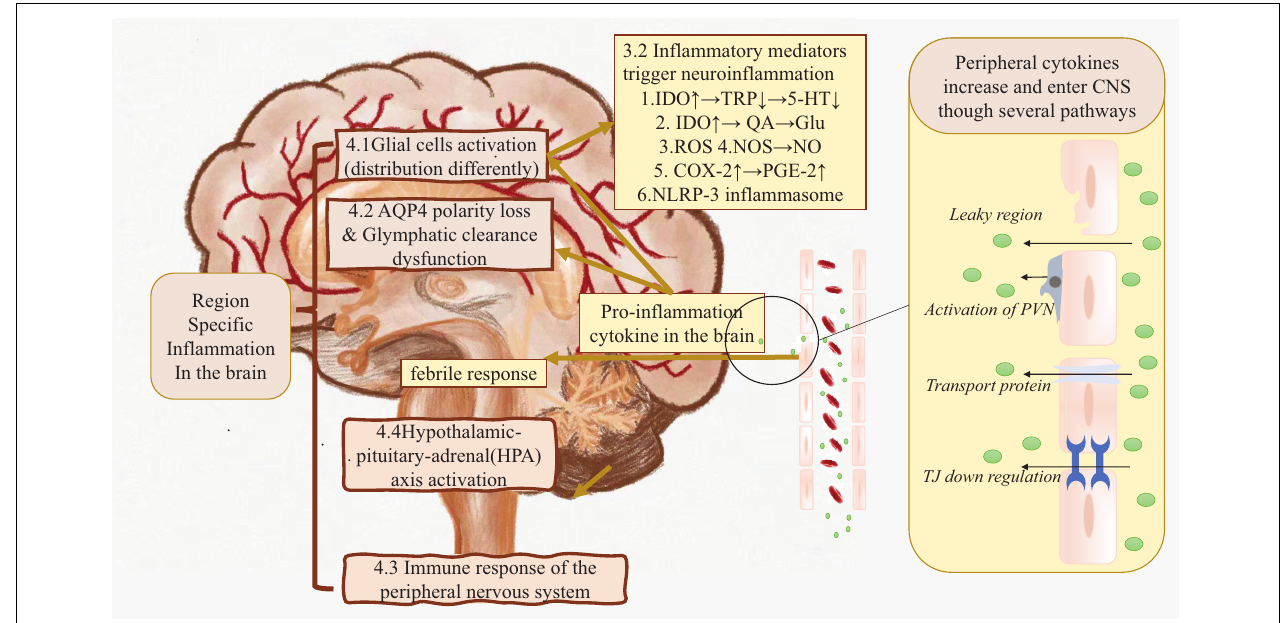
FIGURE 1 | The real root of peripheral inflammation induced neuroinflammation. Right side: In the case of systematic inflammation, peripheral inflammation cytokines are produced. Those cytokines could flow into CNS directly or cause BBB leakage, finally cause pro-inflammation cytokine in the brain increasing. Left side: Those cytokines in CNS triggers inflammation by activating glial cells, causing glymphatic clearance dysfunction etc. Brown part: These factors may cause region-specific neuroinflammation. AQP4, Aquaporin 4; BBB, Blood-brain Barrier; C1q, Compliment 1q; CNS, Central nervous system; COX-2, Cyclooxygenase; Glu, Glutamate; HPA axis, Hypothalamic–pituitary–adrenal axis; IDO, Indoleaminepyrrole 2,3-dioxygenase; IL-1 α , Interleukin-1 α ; NLRP-3, NACHT-LRR and pyrin (PYD) domain-containing protein-3; NO, Nitric oxide; NOS, Nitric oxide synthase; PGE-2, Prostaglandin E2; PNS, Peripheral nervous system; PSNS, parasympathetic nervous system; PVN, Perivascular macrophages; QA, Quinolinic acid; ROS, Reactive oxygen species; SNS, Sympathetic nervous system; TJ, Tight junction; TNF- α , Tumor necrosis factor- α ; TRP, Tryptophan; 5-HT,